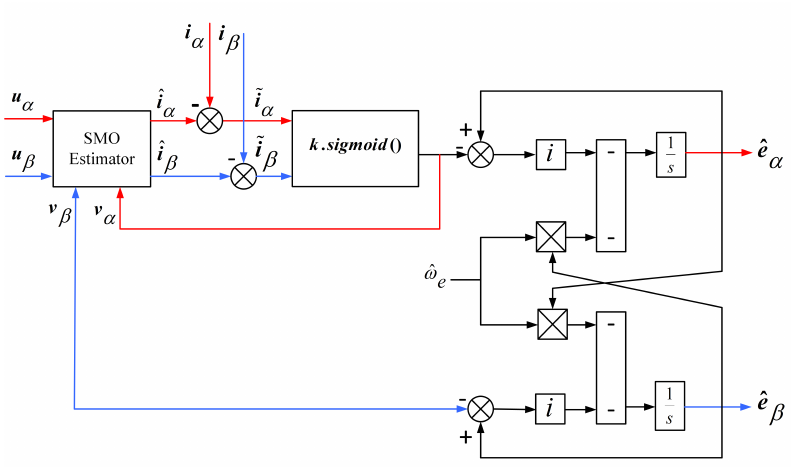
Figure 8. Block diagram of adaptive SMO method [36].